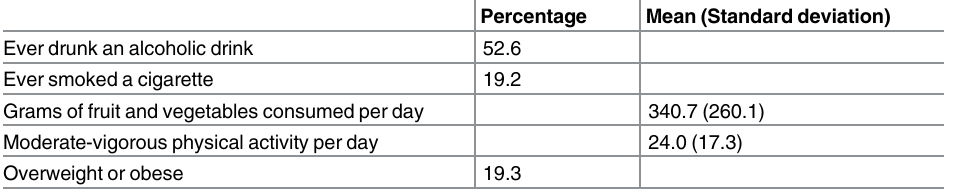
Table 3. Sample characteristics for health-related behaviours.